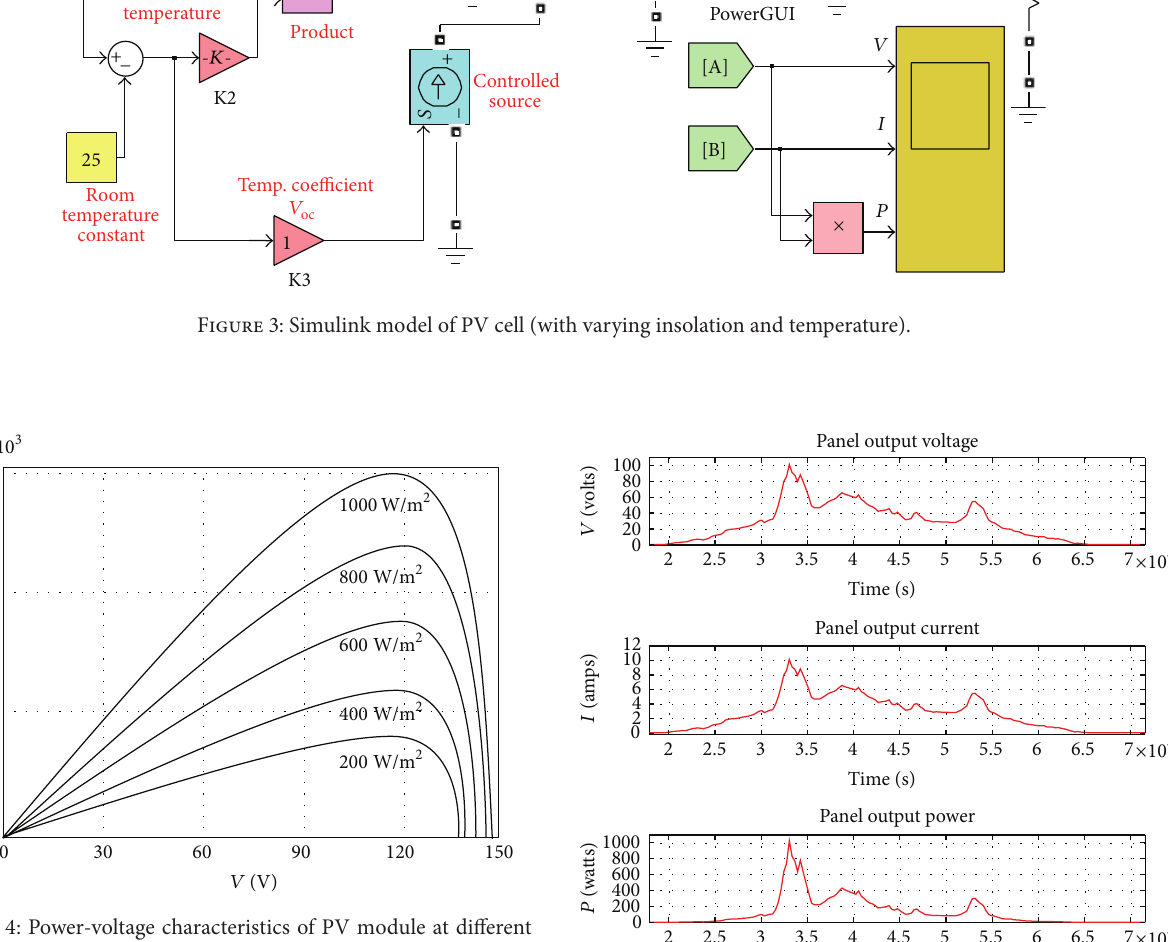
where 𝑆 𝑘 (𝑘 = 0, 1, . . .) is the variable step size at time